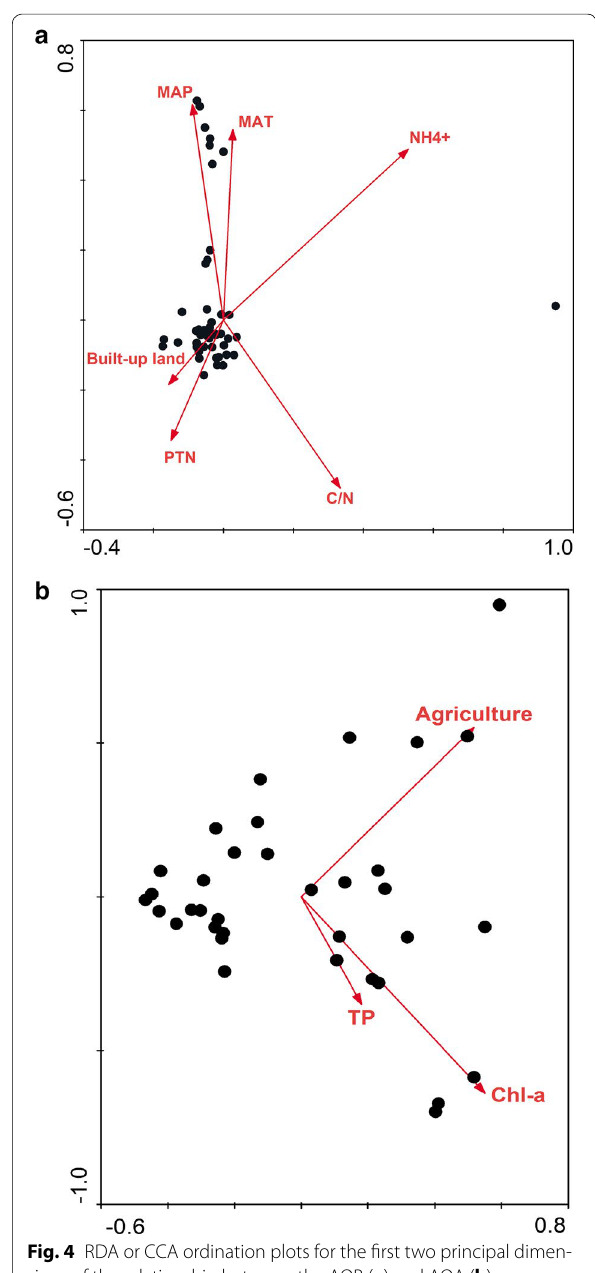
Fig. 4 RDA or CCA ordination plots for the first two principal dimen- sions of the relationship between the AOB ( a ) and AOA ( b ) commu- nity compositions with the environmental